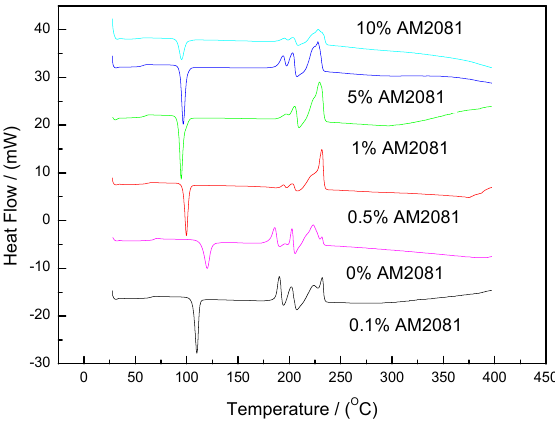
Figure 3. DSC scans of phthalonitrile monomer (2 wt % BAPP mixtures with 0, 0.1, 0.5, 1, 5, and 10 wt % of AM2081 added at 260 °C).